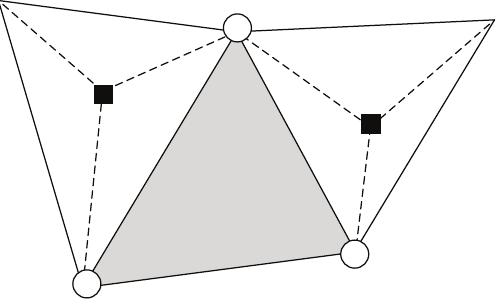
Figure 3: Modified mesh structure with 2 auxiliary nodes and 6 auxiliary edges.